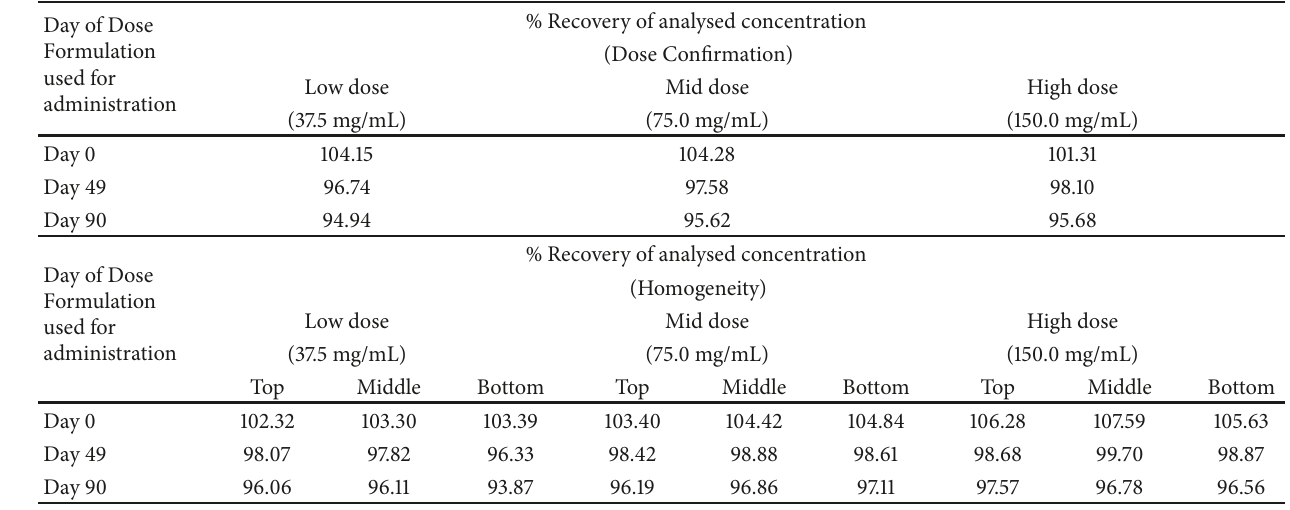
Table 3: Dose confirmation & homogeneity analysis.